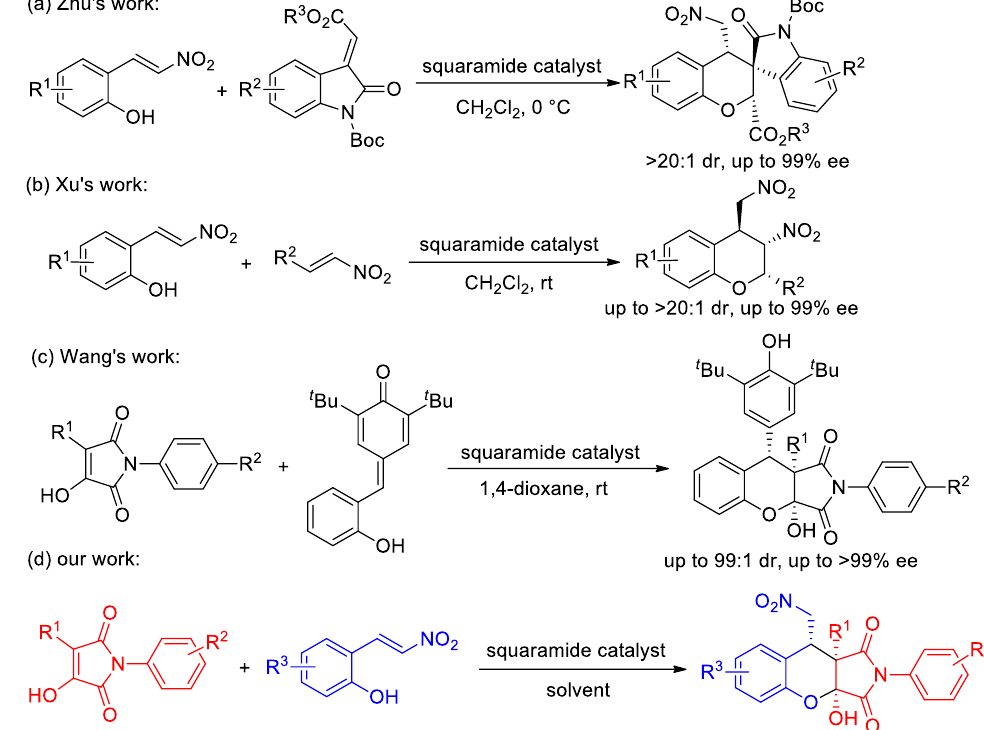
Figure 1. Representative examples of natural products and biologically active compounds with a ring-fused chroman skeleton.